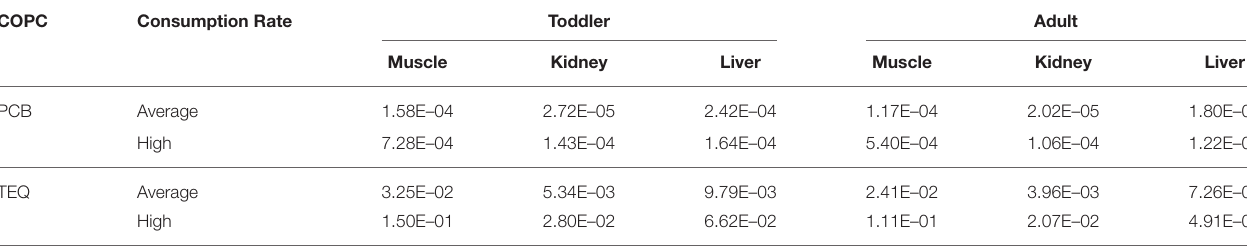
TABLE 6 | HQ values for PCB and TEQ in moose tissue.